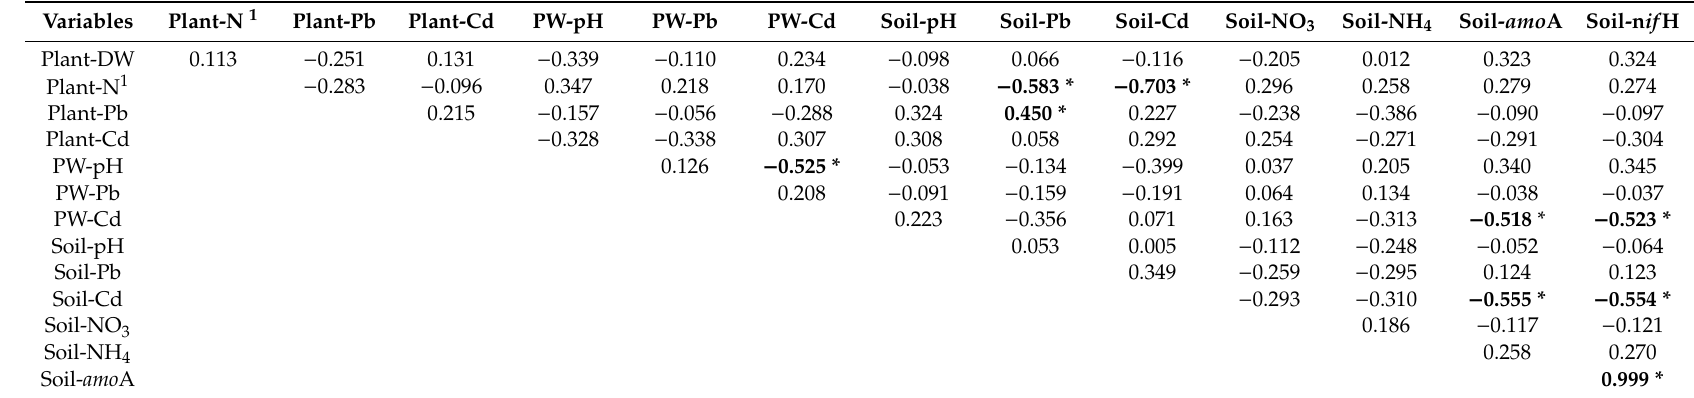
Table 6. Pearson correlation coe ffi cients showing the relationship between soil and plant features of a mixed stand of F. arundinacea Shreb., L. perenne L. and P. pratensis L. (without the unplanted control). The asterisk after values in bold indicate significant correlations at the 0.05 level (2-tailed). PW, pore